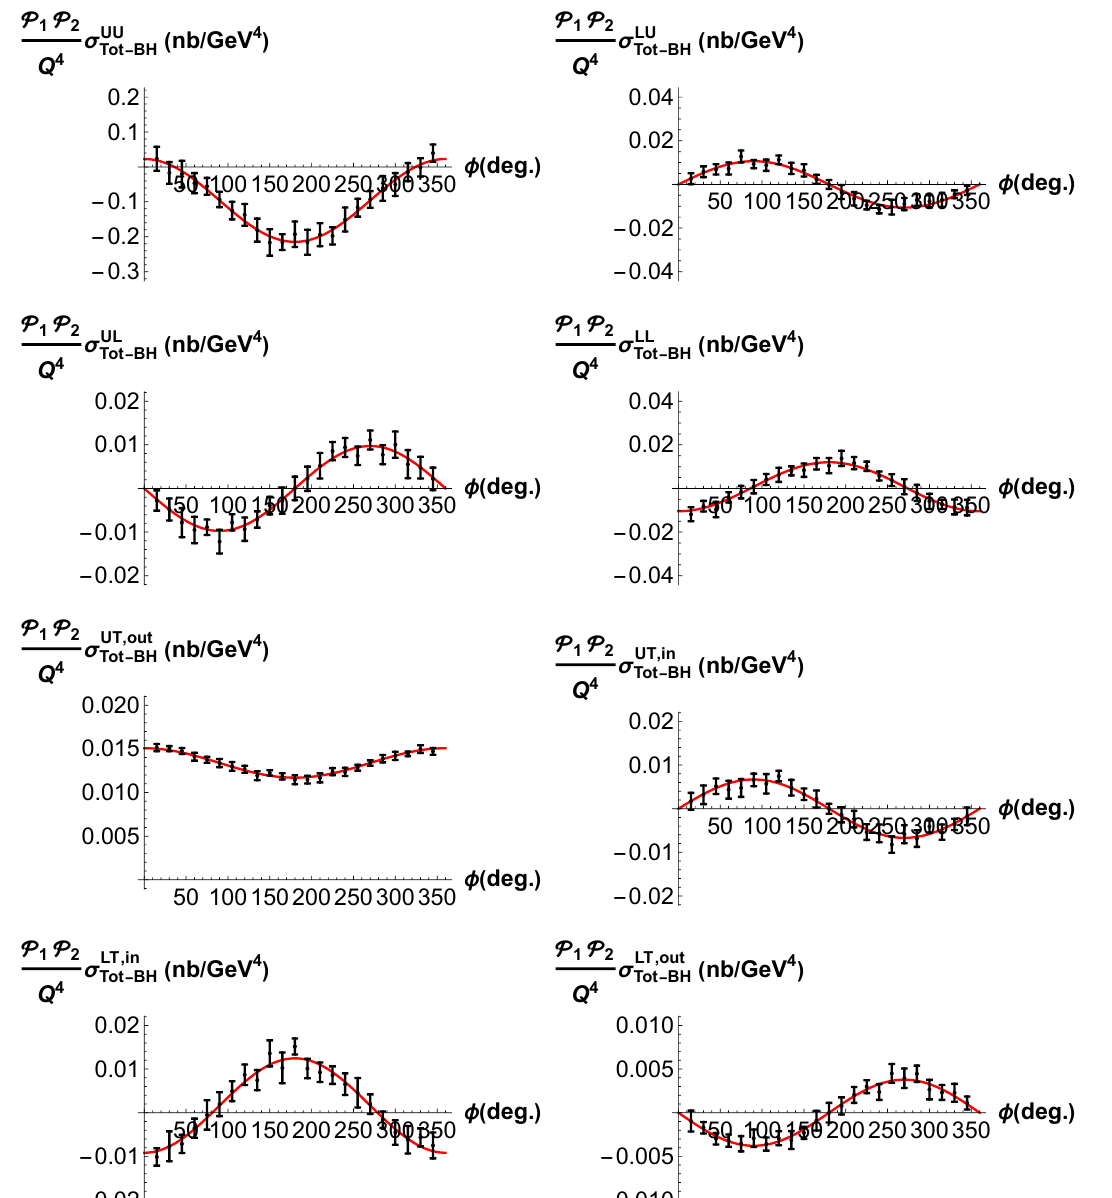
Figure 7. 8 generated DVCS pseudo-cross sections at E b = 10 . 6 GeV using the data in table 4. All polarized cross sections have been taken with their helicity at +1 / 2 , which is equivalent to taking ( σ + − σ − ) / 2 . The UT and LT cross sections have been integrated over 1 points and their uncertainties do not attempt to realistically represent real data at any particular facility, but merely use randomized statistical uncertainties ∼ 25%